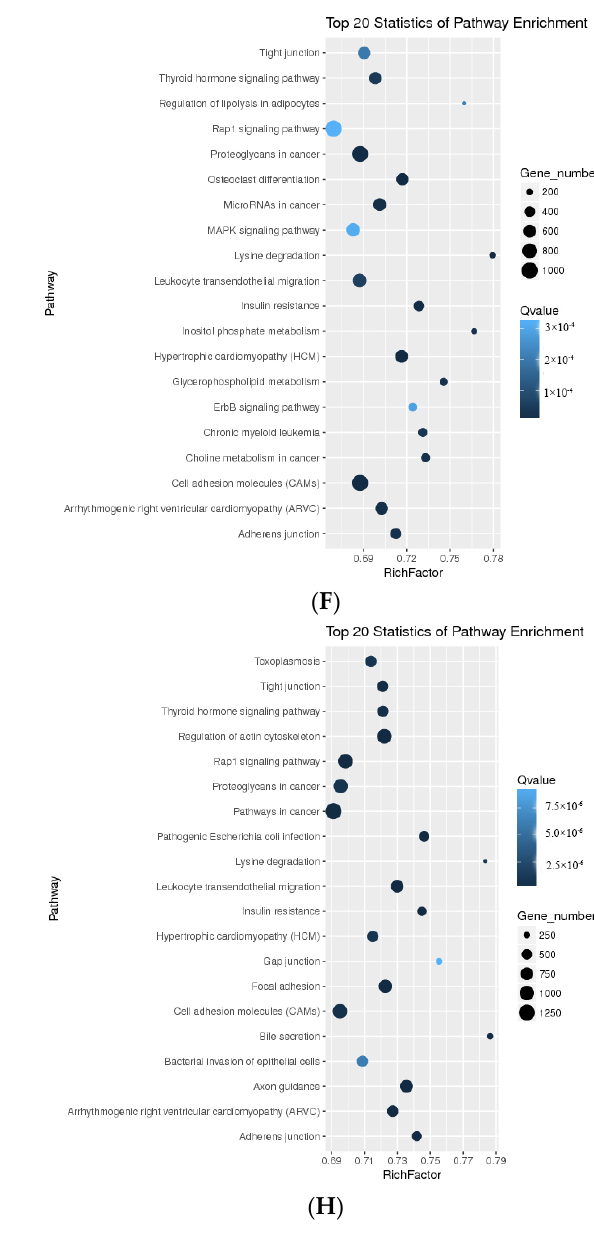
Figure 3. Crucial pathways were clustered from DE lncRNA trans-related genes. ( A ). Gene ontology (GO) function of differentially expressed lncRNA-related mRNAs was classified and analyzed according to trans effect analysis in castrated and intact pig backfat tissues. ( B ). KEGG enrichment analyzed according to trans effect analysis in castrated and intact pig backfat tissues. ( C ). Gene ontology (GO) function of differentially expressed known DEmiRNA target mRNAs in castrated and intact pig abdominal tissues. ( D ). KEGG enrichment analysis according to known DEmiRNA target mRNAs in castrated and intact pig abdominal tissues. Gene ontology (GO) function was classified, and KEGG enrichment was analyzed according to related mRNAs. ( E ). Gene ontology (GO) function of differentially expressed lncRNA-related mRNAs was classified and analyzed according to trans effect analysis inS castrated and intact pig abdominal tissues. ( F ). KEGG enrichment analyzed according to trans effect analysis in castrated and intact pig abdominal tissues. ( G ). Gene ontology (GO) function of differentially expressed known DEmiRNA target mRNAs in castrated and intact pig abdominal tissues. ( H ). KEGG enrichment analysis according to known DEmiRNA target mRNAs in castrated and intact pig abdominal tissues .